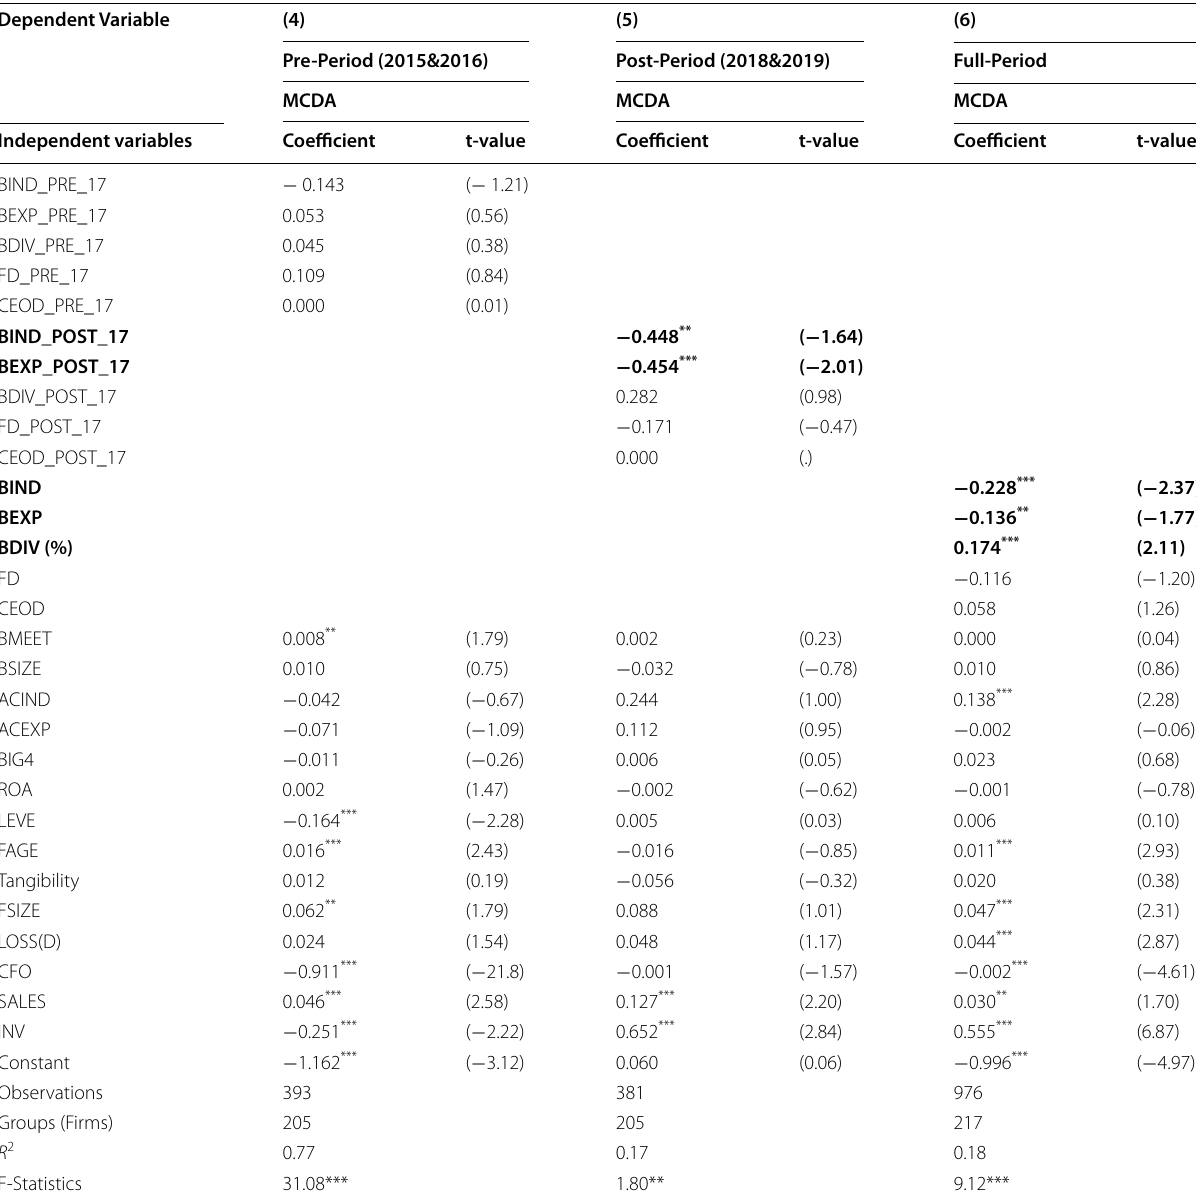
Table 10 Regression results of board of directors attributes and earnings management with the pre- and post-CCG 2017 dummies